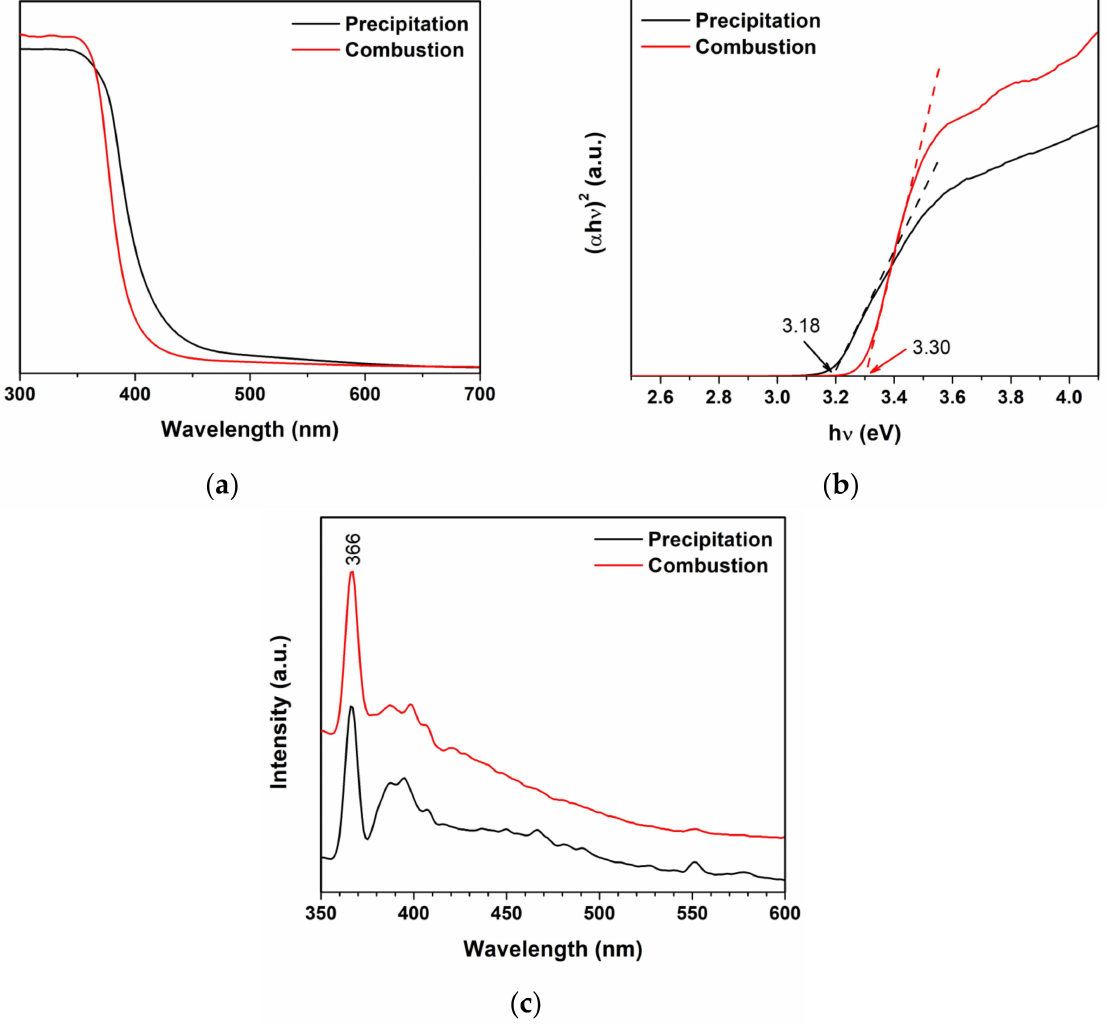
Figure 8. ( a ) absorbance, ( b ) band gap energy analysis, and ( c ) fluorescence spectra of ZnO